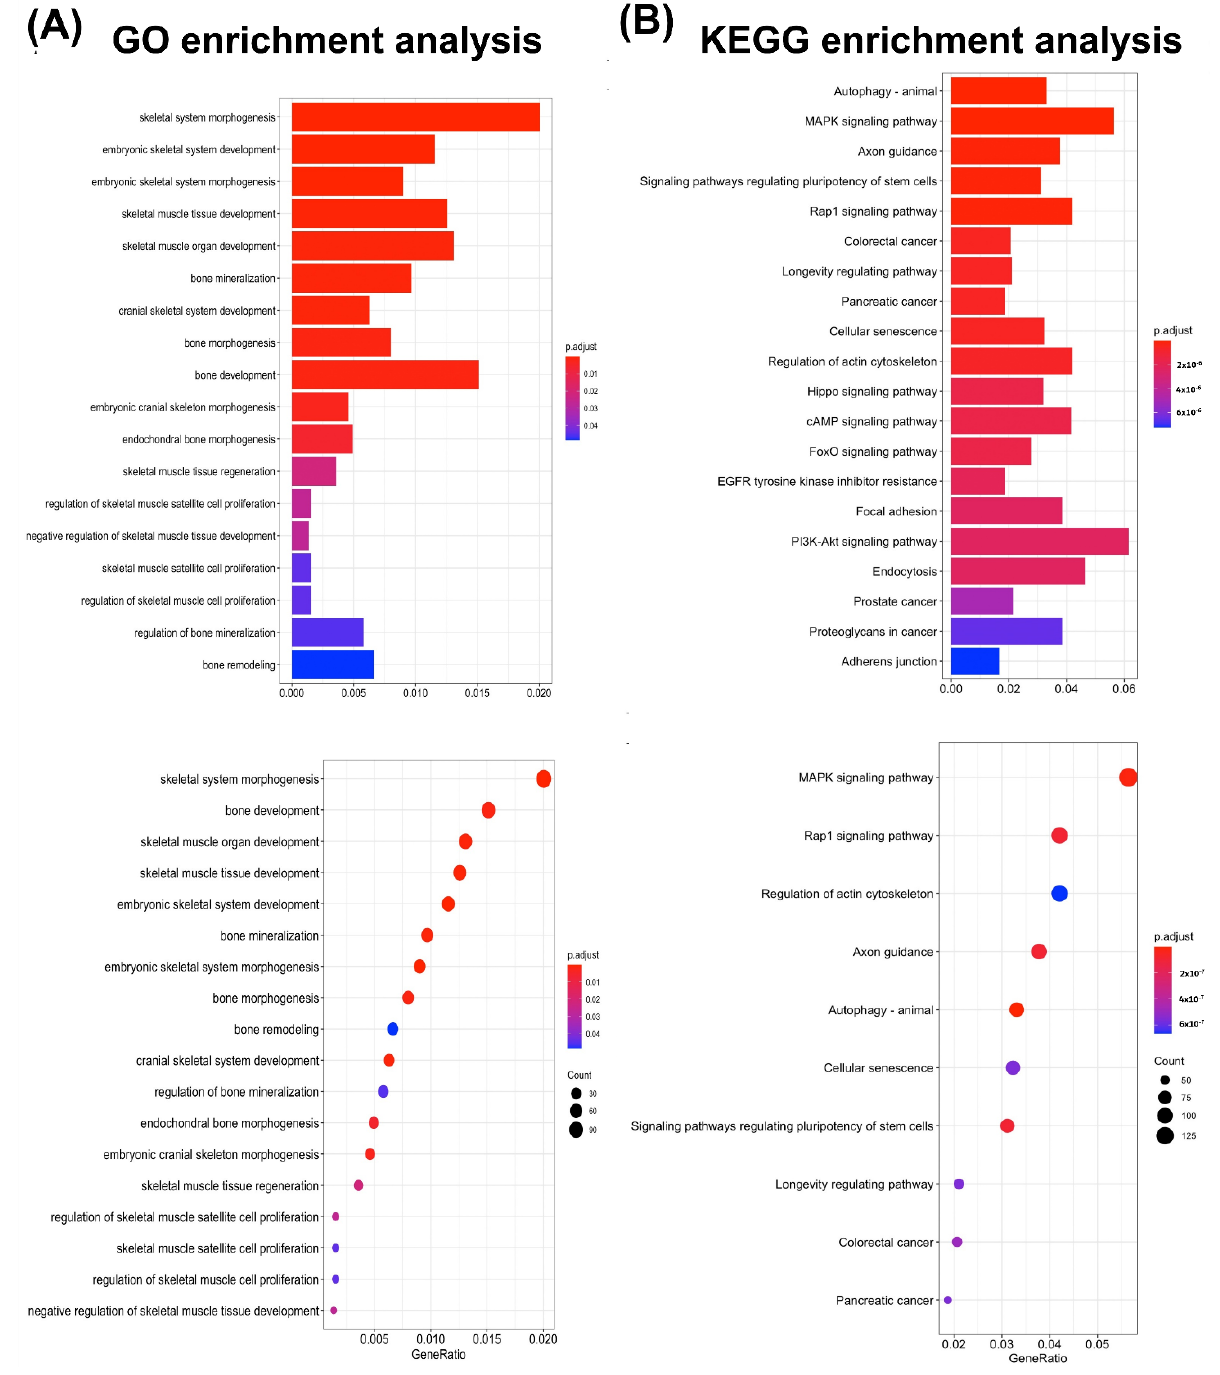
Figure 8. Gene ontology (GO) enrichment and Kyoto Encyclopedia of Genes and Genomes (KEGG) pathway analysis. GO pathway and KEGG pathway analyses were performed for the target genes of miRNAs enriched in ADSC-EVs. ( A ) GO enrichment analysis results. ( B ) KEGG enrichment analysis results. Bar and dot plots of GO and KEGG are shown ( n = 3).